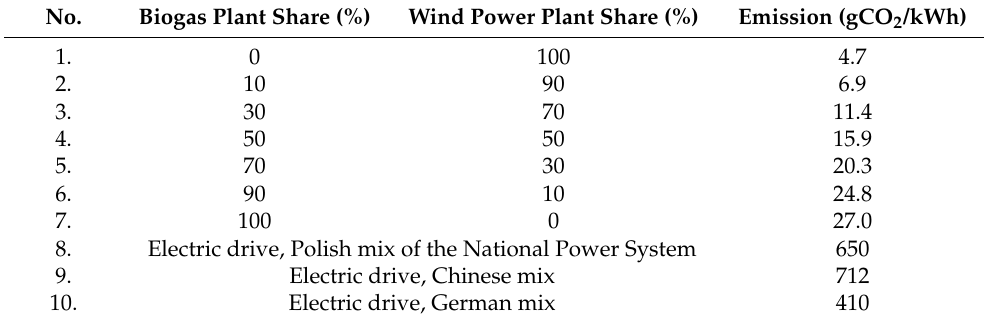
Table 2. Type of a mix: wind/biogas and CO 2 emissivity for electricity production [10,50]. No.